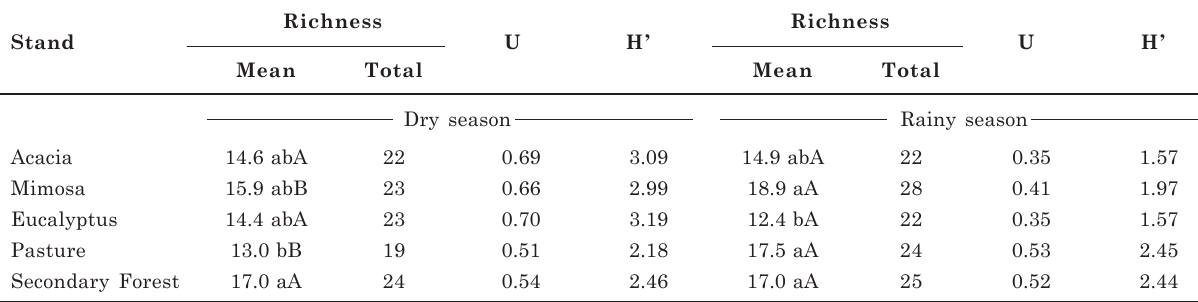
Values followed by the same small letter in columns and the same capital letter in rows are statistically equal by the Kruskal- Wallis test (p <